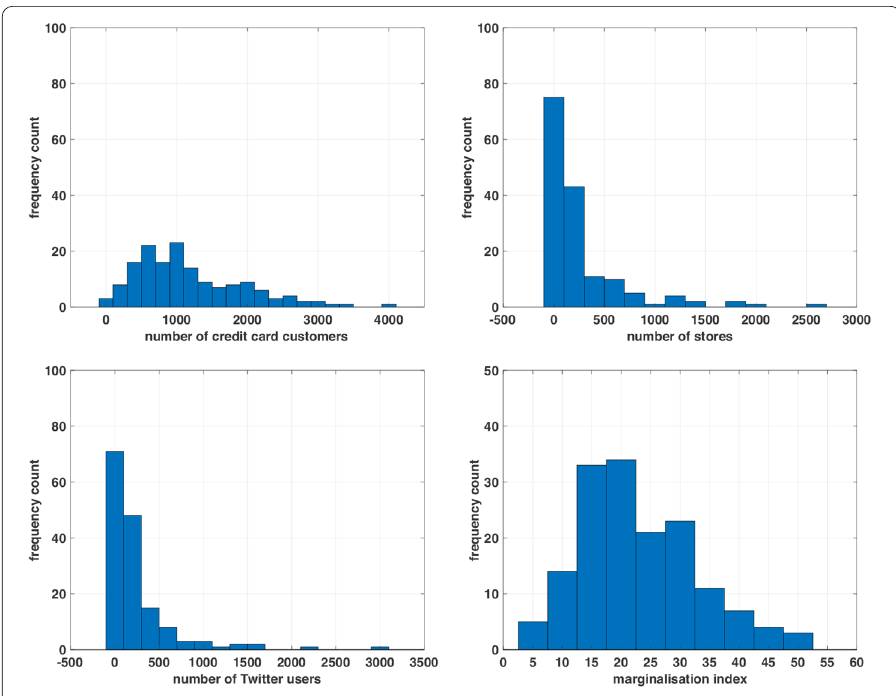
Figure 9 Histograms of (Top Left) the number of credit card customers, (Top Right) the number of stores, (Bottom Left) the number of Twitter users, and (Bottom Right) the socio-economic status, for neighborhoods in the Latin American metropolitan area